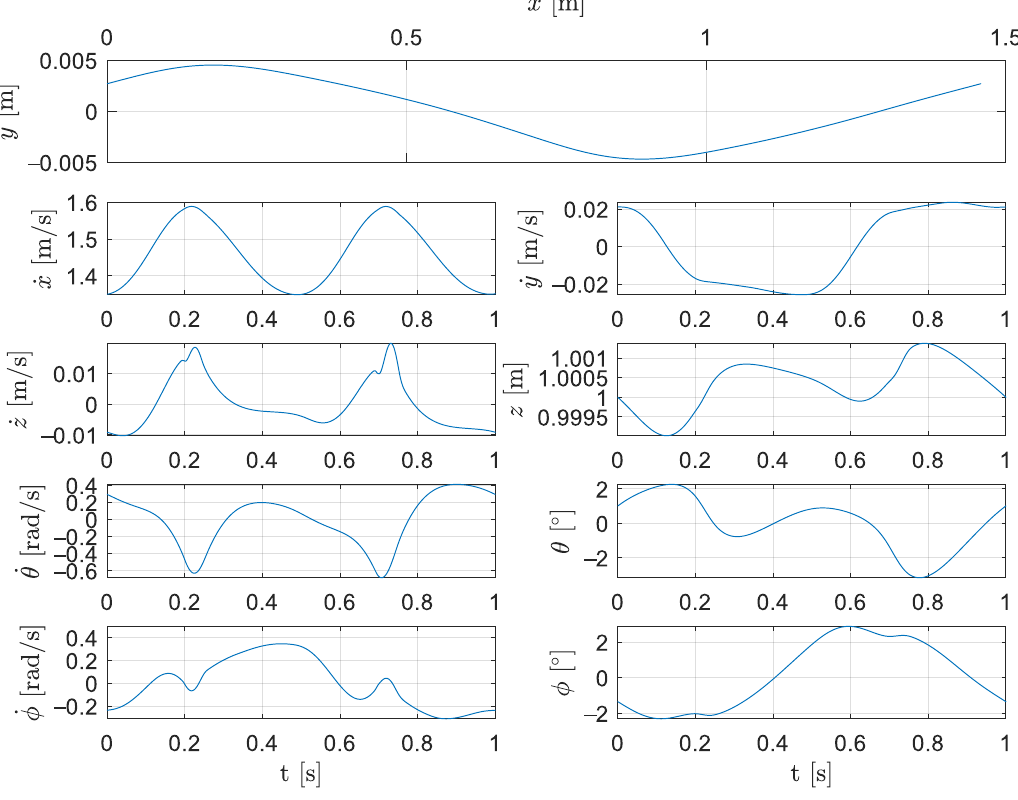
Figure 9. Trajectory and attitude of the selected optimal solution.